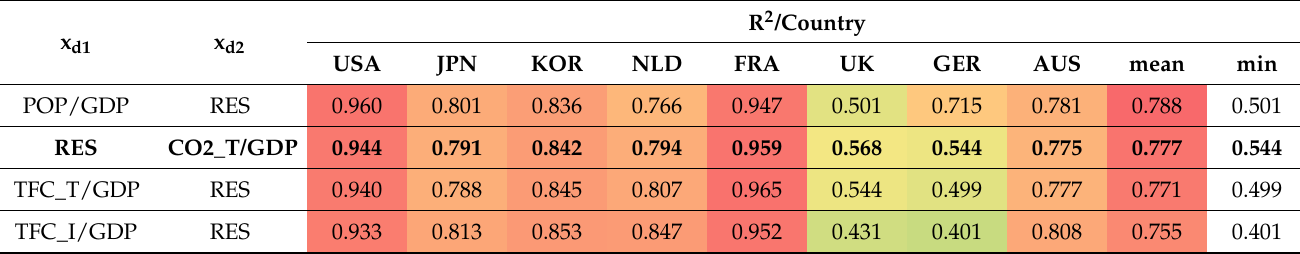
Table 2. The values of the coefficient of determination for the linear regression R 2 for selected combinations of RDD and parameters x d1 and x d2 —four pairs with the highest mean R 2 for individual countries were presented. Color agenda: red—the highest value, green—the lower value; the best combination is bold. x